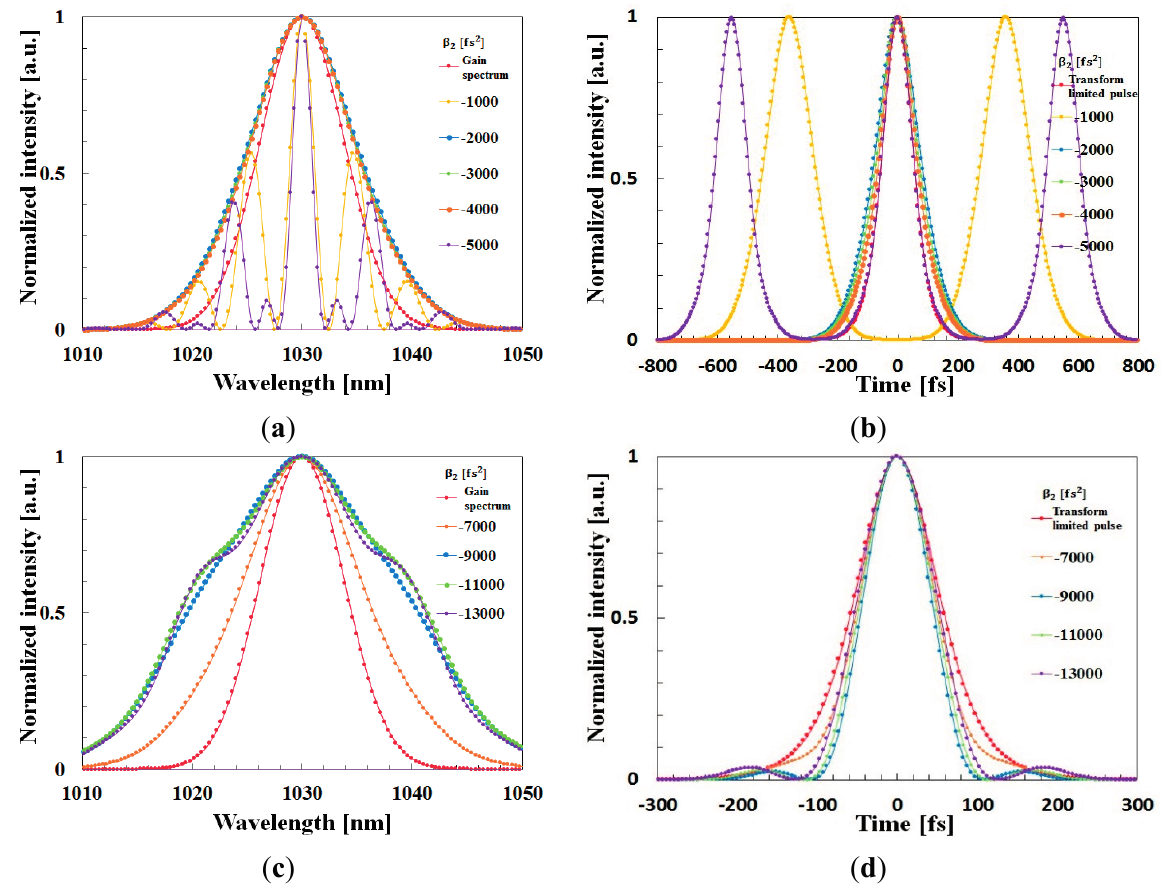
Figure 5. ( a ) Output spectra and ( b ) output pulse profiles for the SOD varied from − 1000 fs 2 to − 5000 fs 2 ; ( c ) Output spectra and ( d ) output pulse profiles of the SOD varied from − 6000 fs 2 to − 13,000 fs 2 . The cavity loss is 2%.